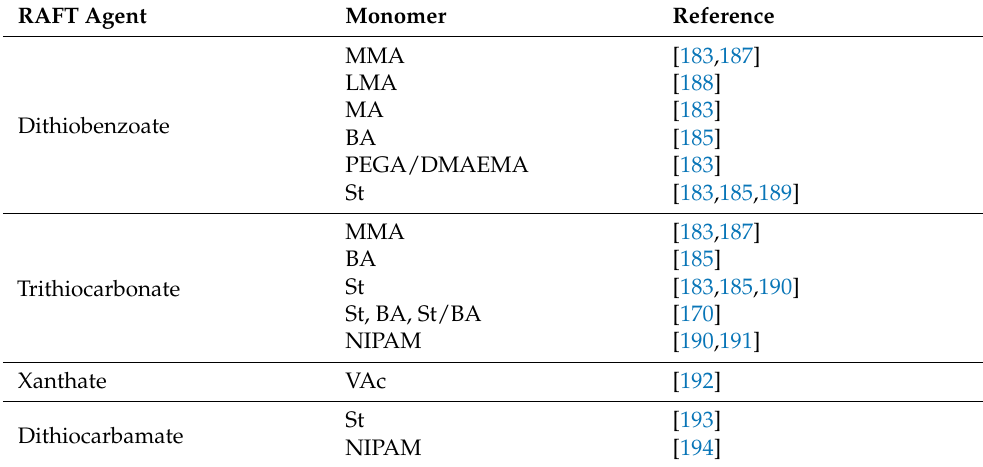
Table 6. Examples of end-group removal with the use of